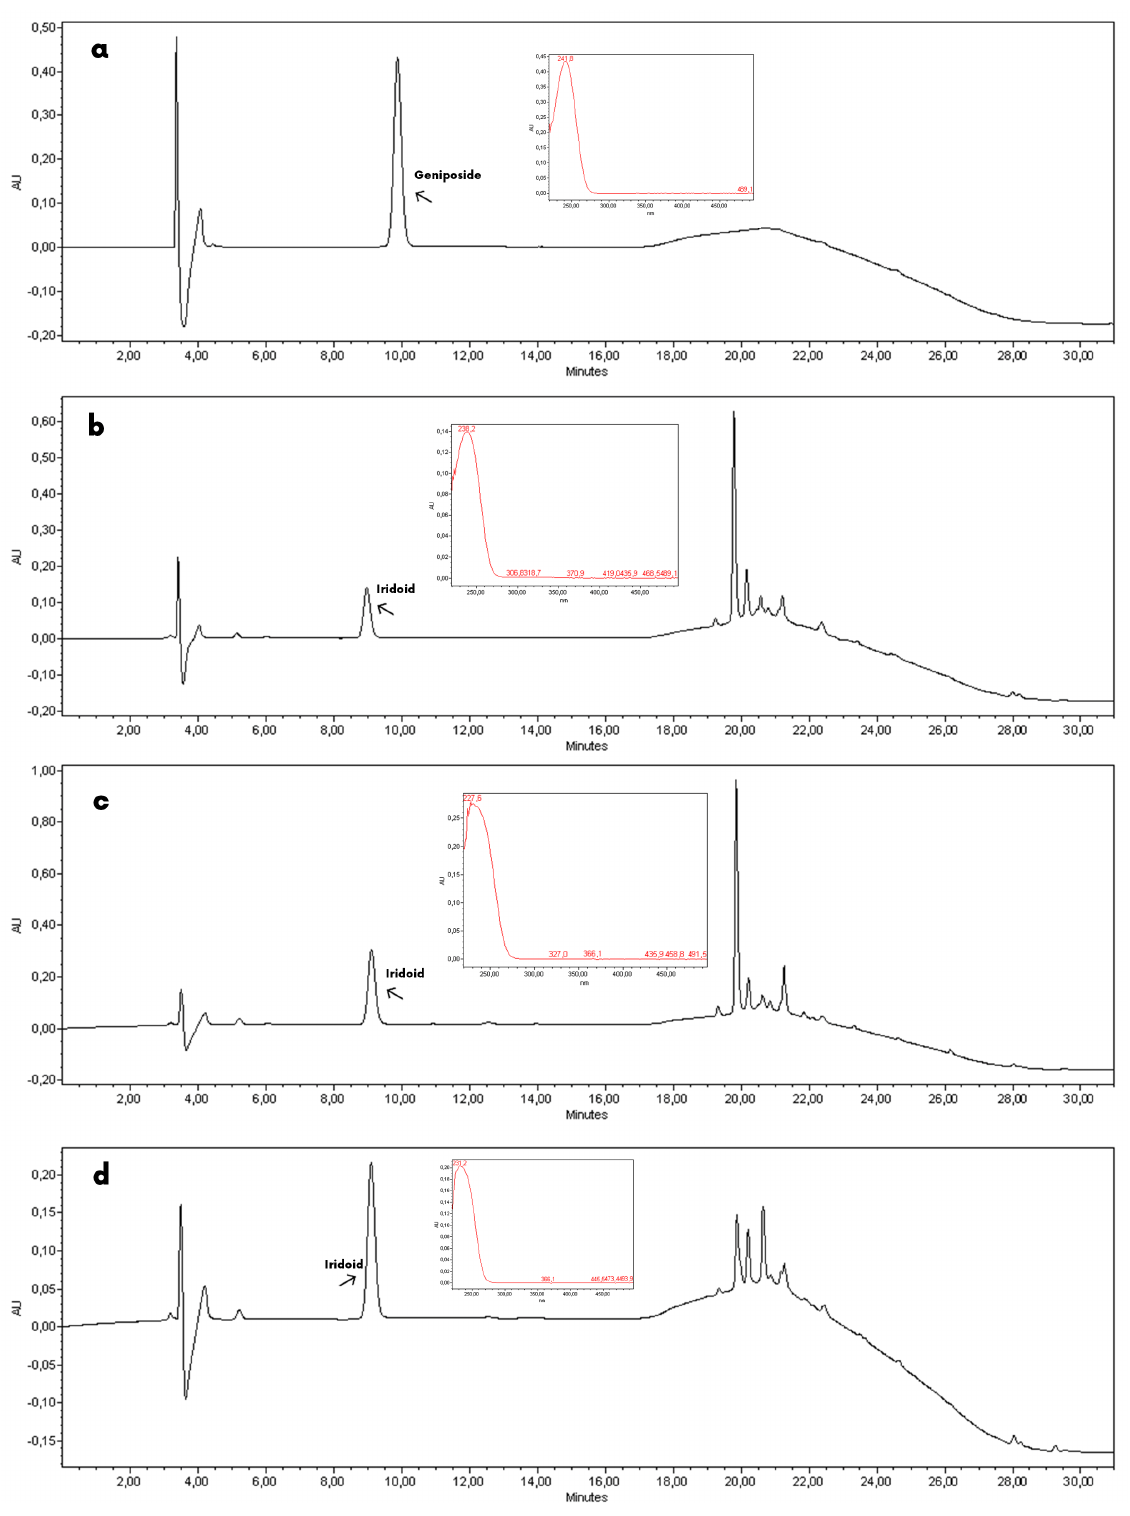
Figure 3. Chromatograms at 240 nm and UV-DAD spectra for peak at 9.8 minutes: (a) Geniposide standard at 500.0 μg mL -1 and Extracts of (b) Leaves 2010 (c) Flowers 2011 (d) Stems 2012 of Verbena